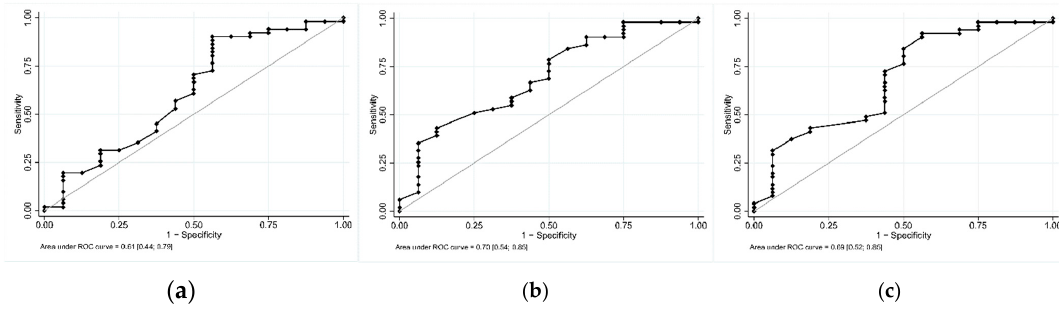
Figure 2. Receiver operating characteristic (ROC) curves of blue percentile for iron deficiency diagnosis. ( a ) Full sclera method; ( b ) manual sclera method; and ( c ) semi-automated sclera method.